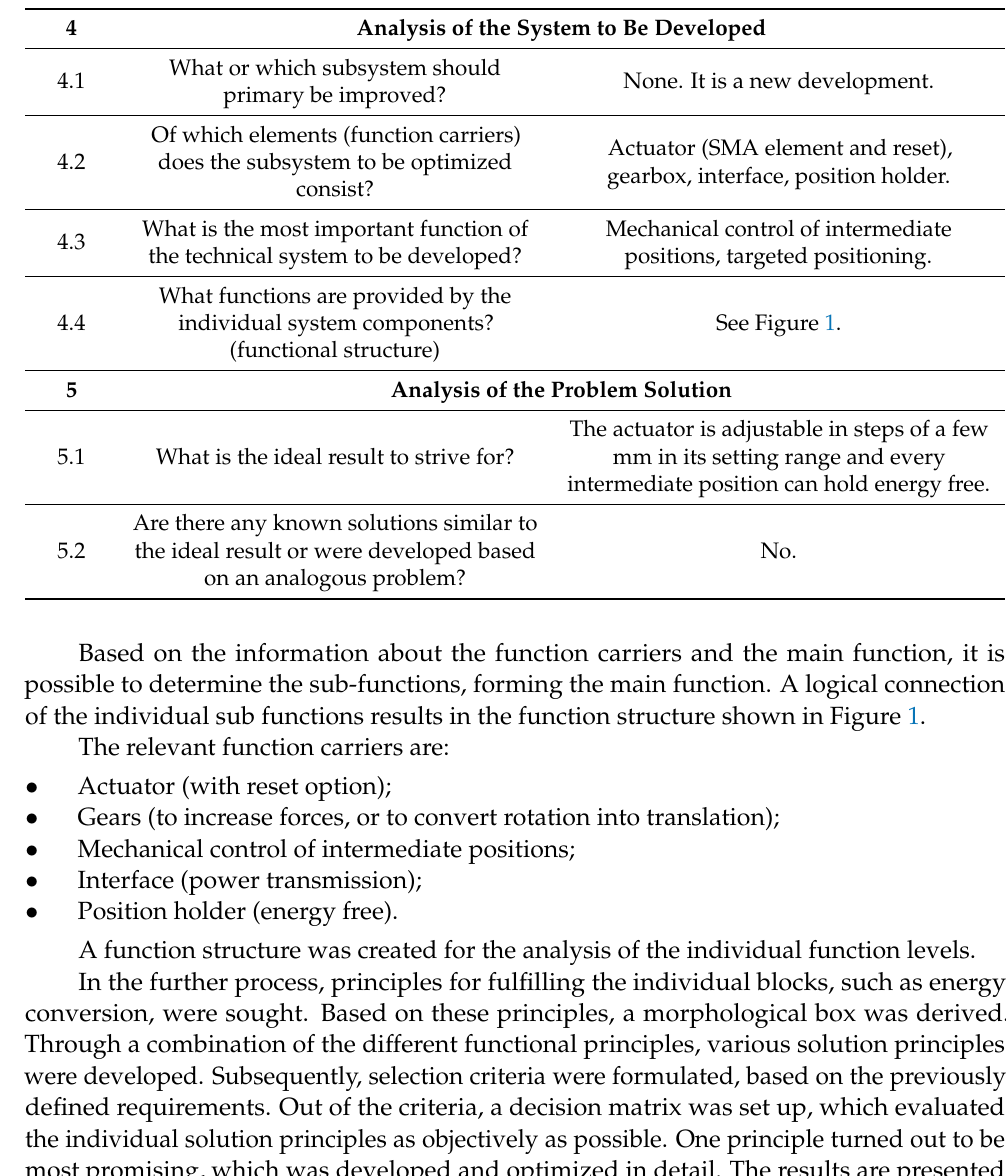
Table 2. SMA innovation checklist